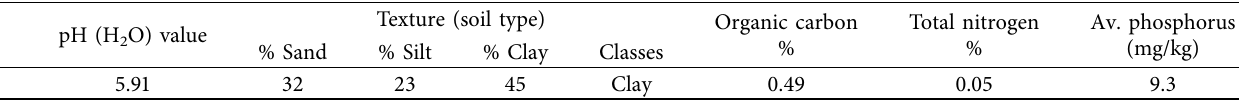
Table 3: Physiochemical properties of experimental soil.